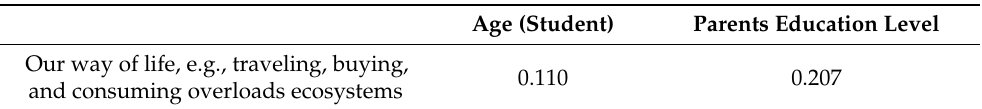
Table 8. The student’s degree of agreement and the school age of the parent with more education was correlated by Spearman’s